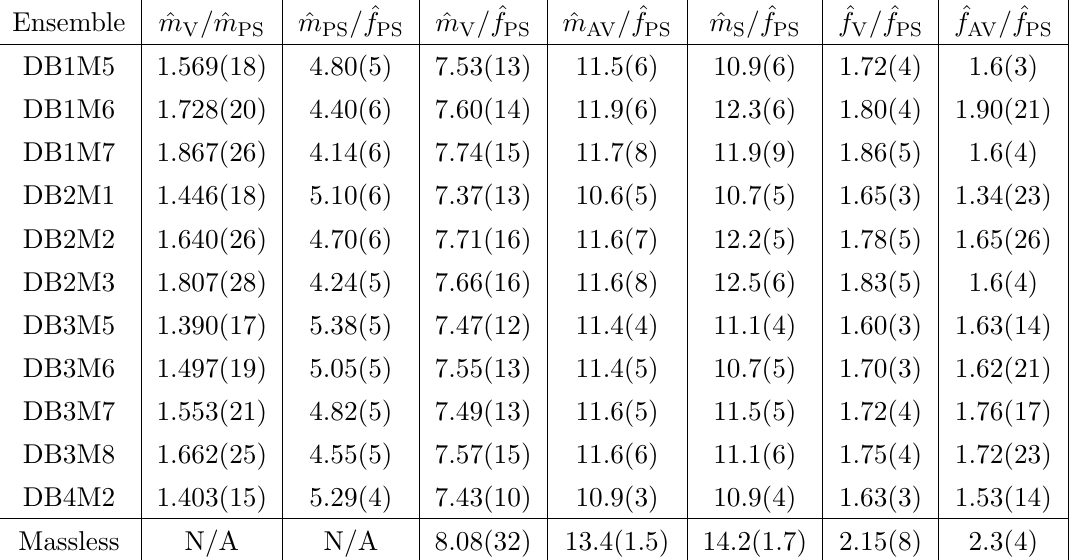
Table 11. Ratios of meson masses and decay constants, extrapolated to the continuum limit by the subtraction method explained in section 4.3. We restrict the data to the eleven ensembles for which the subtraction of e(cid:11)ects due to the (cid:12)nite lattice spacing can be done for all measurable quantities. In the last row, we report the results of the continuum and massless extrapolation, obtained by applying eqs. (4.13) and (4.14) to the eleven ensembles. Statistical and systematic uncertainties have been added in